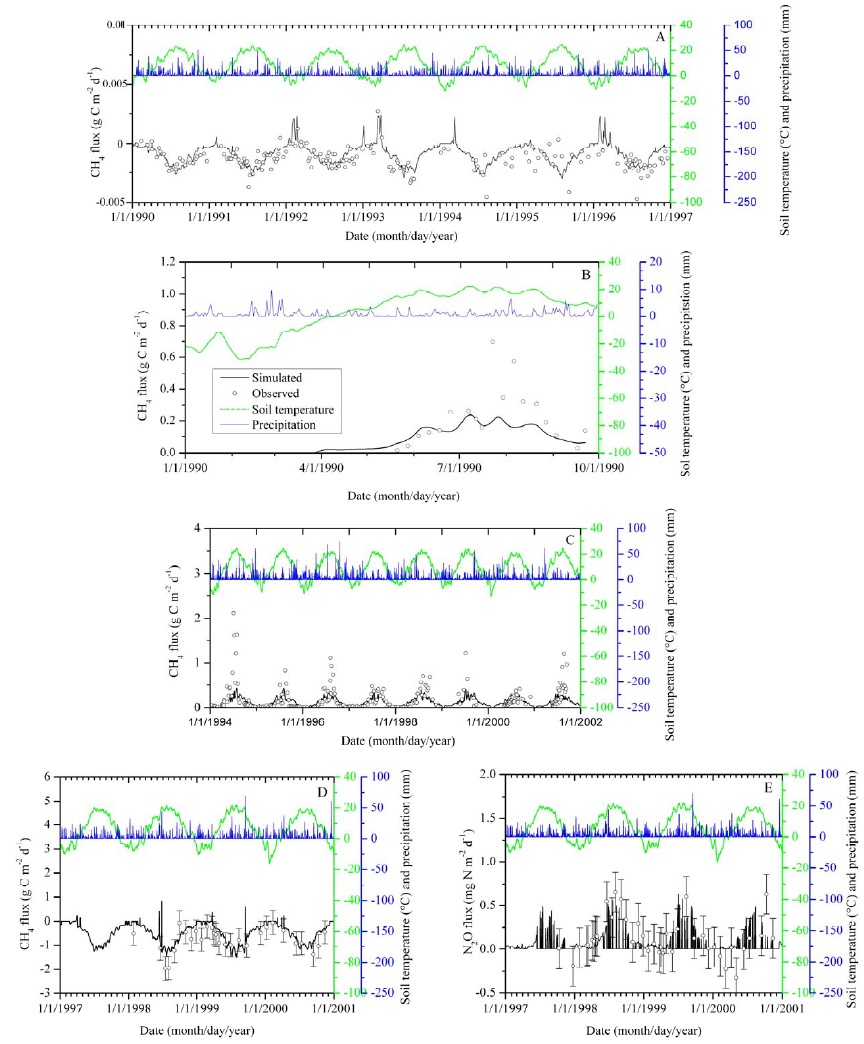
Fig. 5. Comparison of the DLEM-estimated CH 4 and N 2 O fluxes with field observations – (A) CH 4 flux in Durham Forest (42 ◦ N, 73 ◦ W) (TRAGNET); (B) CH 4 flux in Alaska wetland (64.8 ◦ N, 147.7 ◦ W) (TRAGNET); (C) CH 4 flux in Sallie’s fen (43.21 ◦ N, 71.05 ◦ W) ; (D) CH 4 flux in Hubbard Brook Forest (43.95 ◦ N, 71.74 ◦ W) (Groffman et al., 2006, 2009); (E) N 2 O flux in Hubbard Brook Forest (43.95 ◦ N, 71.74 ◦ W) (Groffman et al., 2006, 2009). The error bars in Fig. 4d and e represent the standard deviations of four or five replicated obser- vations; the regression models for these five site-level validations are: Modeled=0.9389 × observed, r =0.562, P < 0.001 for (A); Mod- eled= 0.5882 × observed, r =0.628, P < 0.001 for (B); Modeled=0.8795 × observed, r =0.502, P < 0.001 for (C) when fluxes higher than 1000mgCm − 2 day − 1 were removed; Modeled=0.7937 × observed, r =0.595, P < 0.001 for (D); Modeled=0.7042 × observed, r =0.633, P < 0.001 for